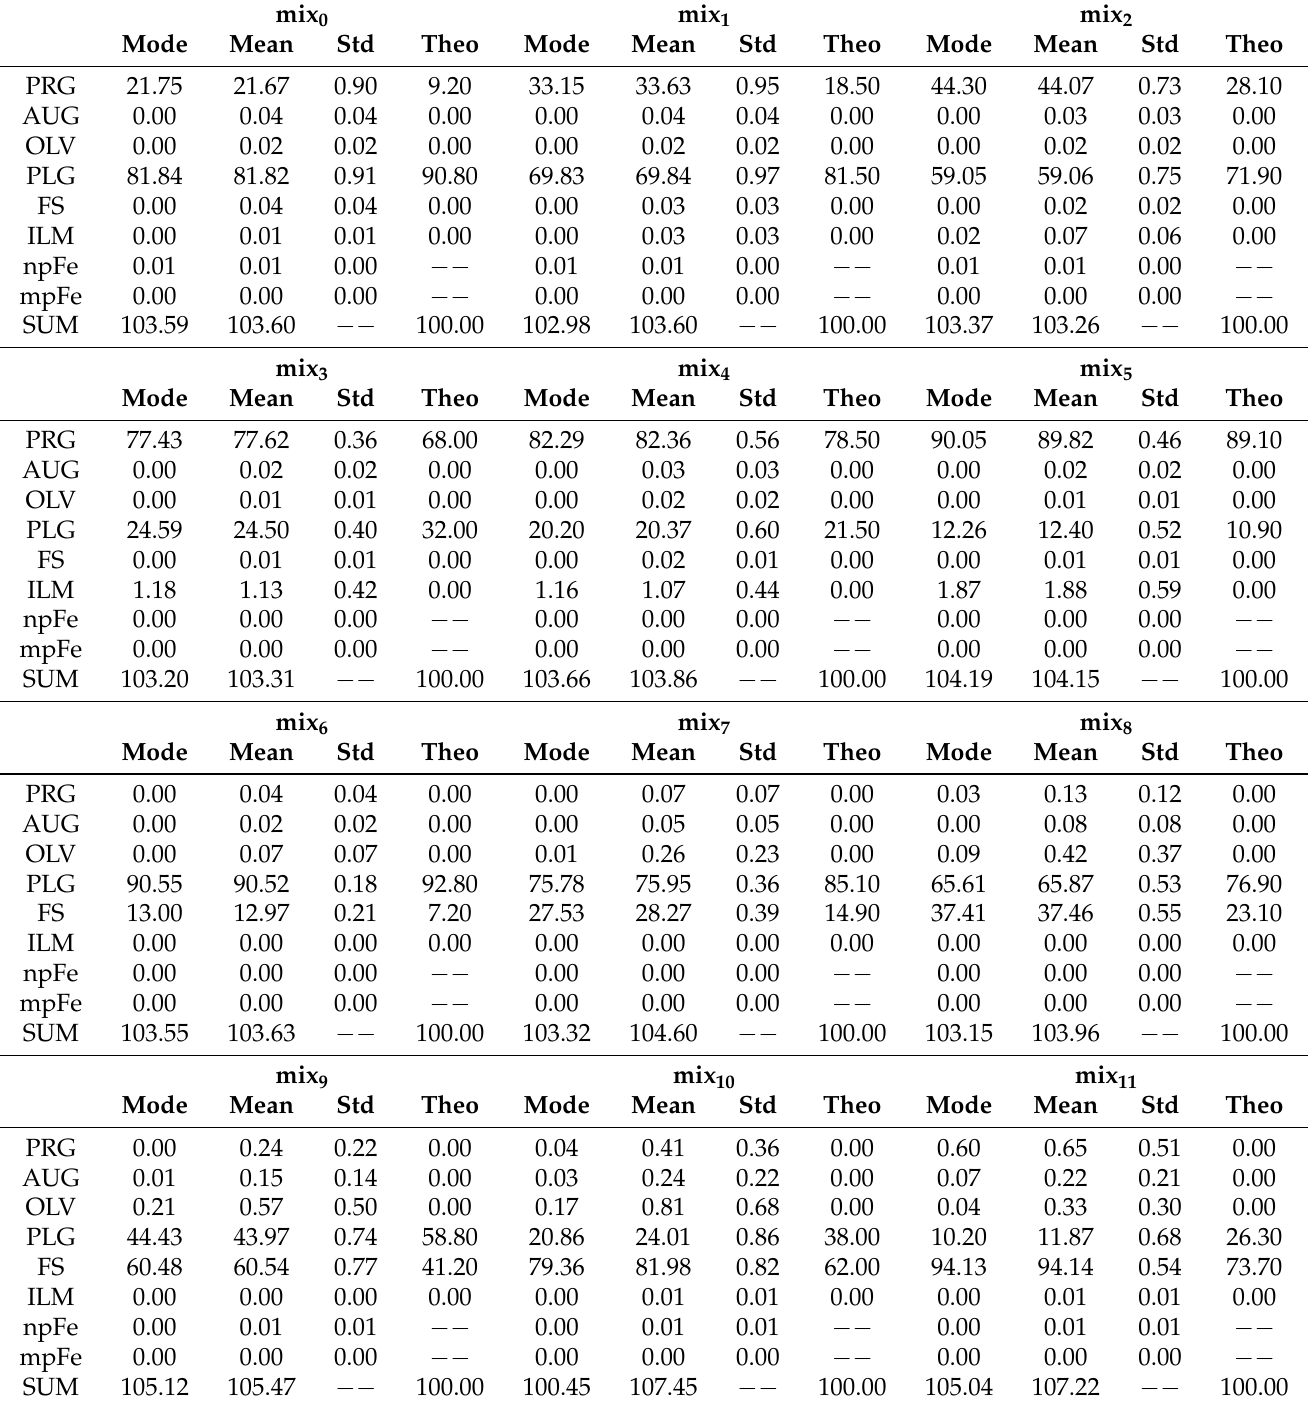
Table A8. Detailed results for the unmixing of fresh laboratory spectra from Rommel et al.